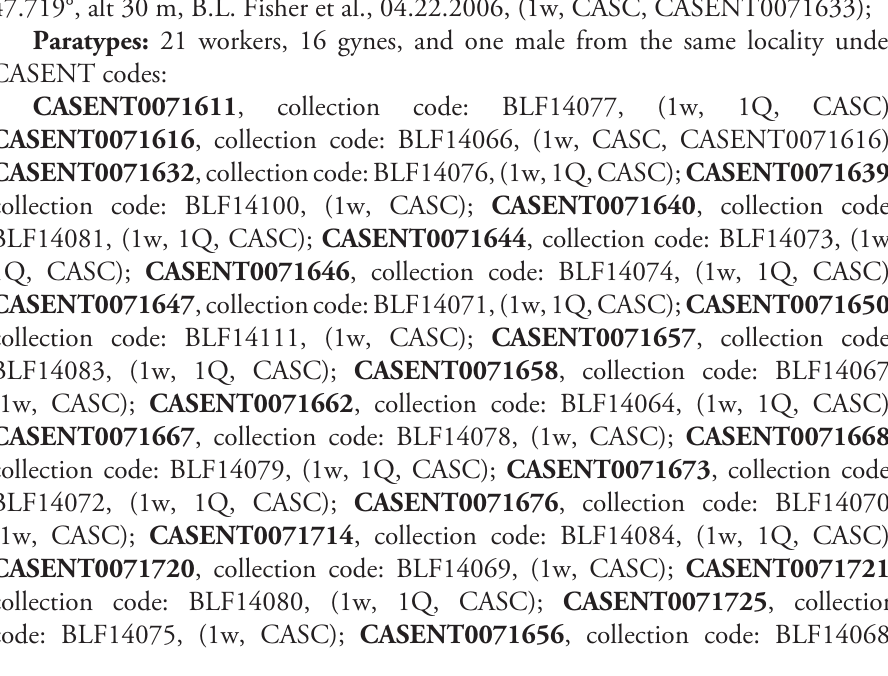
Type material investigated. Holotype: CASENT0071633 , collection code: BLF14082, Réserve Speciale Manombo 24.5 km 228° Farafangana, -23.01583°, 47.719°, alt 30 m, B.L. Fisher et al., 04.22.2006, (1w, CASC, CASENT0071633); Paratypes: 21 workers, 16 gynes, and one male from the same locality